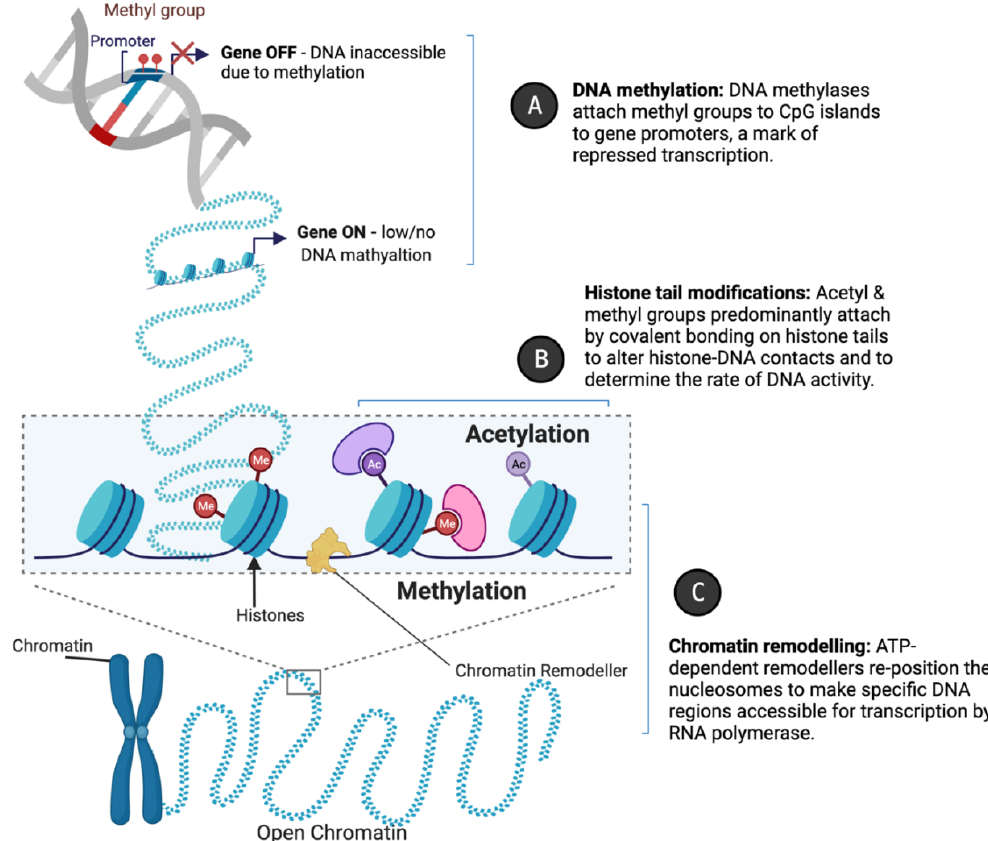
Figure 2. Epigenetic mechanisms of gene regulation. Created with BioRender.com. Epigenetic regu- lators such as ( A ) DNA methylases, ( B ) histone-modifying enzymes, and ( C ) chromatin remodellers modulate gene expression by mediating accessibility to DNA sequences for replicative enzymes or transcription factors. This is achieved through altering the compaction of chromatin by the enzymatic modification of DNA or histones, or by nucleosome